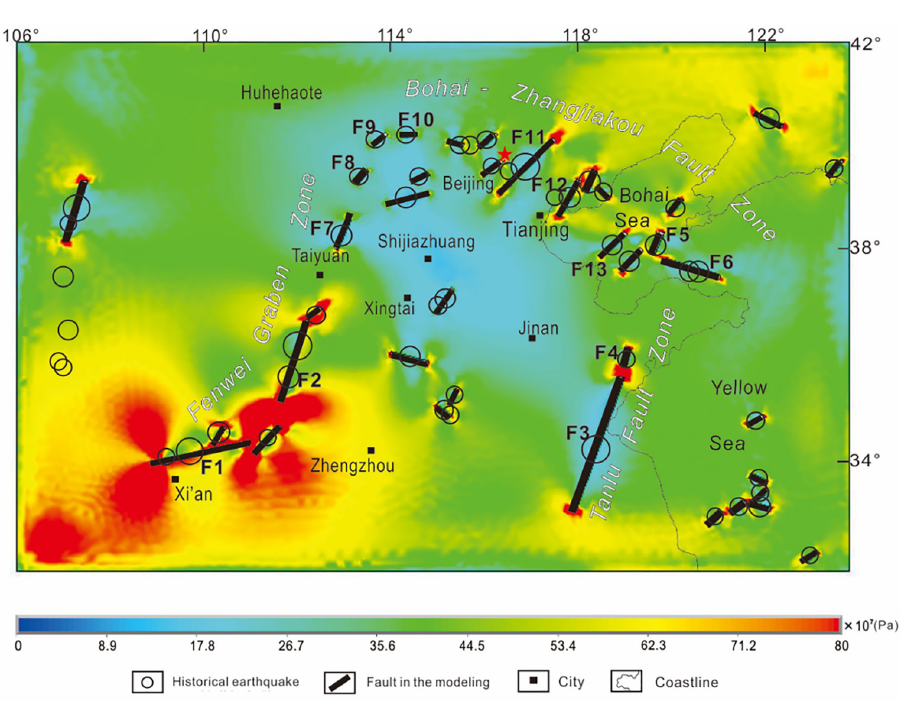
Fig 8. Differential intensity stress (measured in Pa) calculated by the model and historical earthquakes in the CNCB. Black lines denote the seismogenic faults. The highest stress value is located in the southern part of the Fen-wei Graben Zone. The lowest stress value is located in the northern part of the Fen-wei Graben Zone. Moderate stress values are located in the Bohai-Zhangjiakou Fault Zone and the Tan-lu Fault Zone.